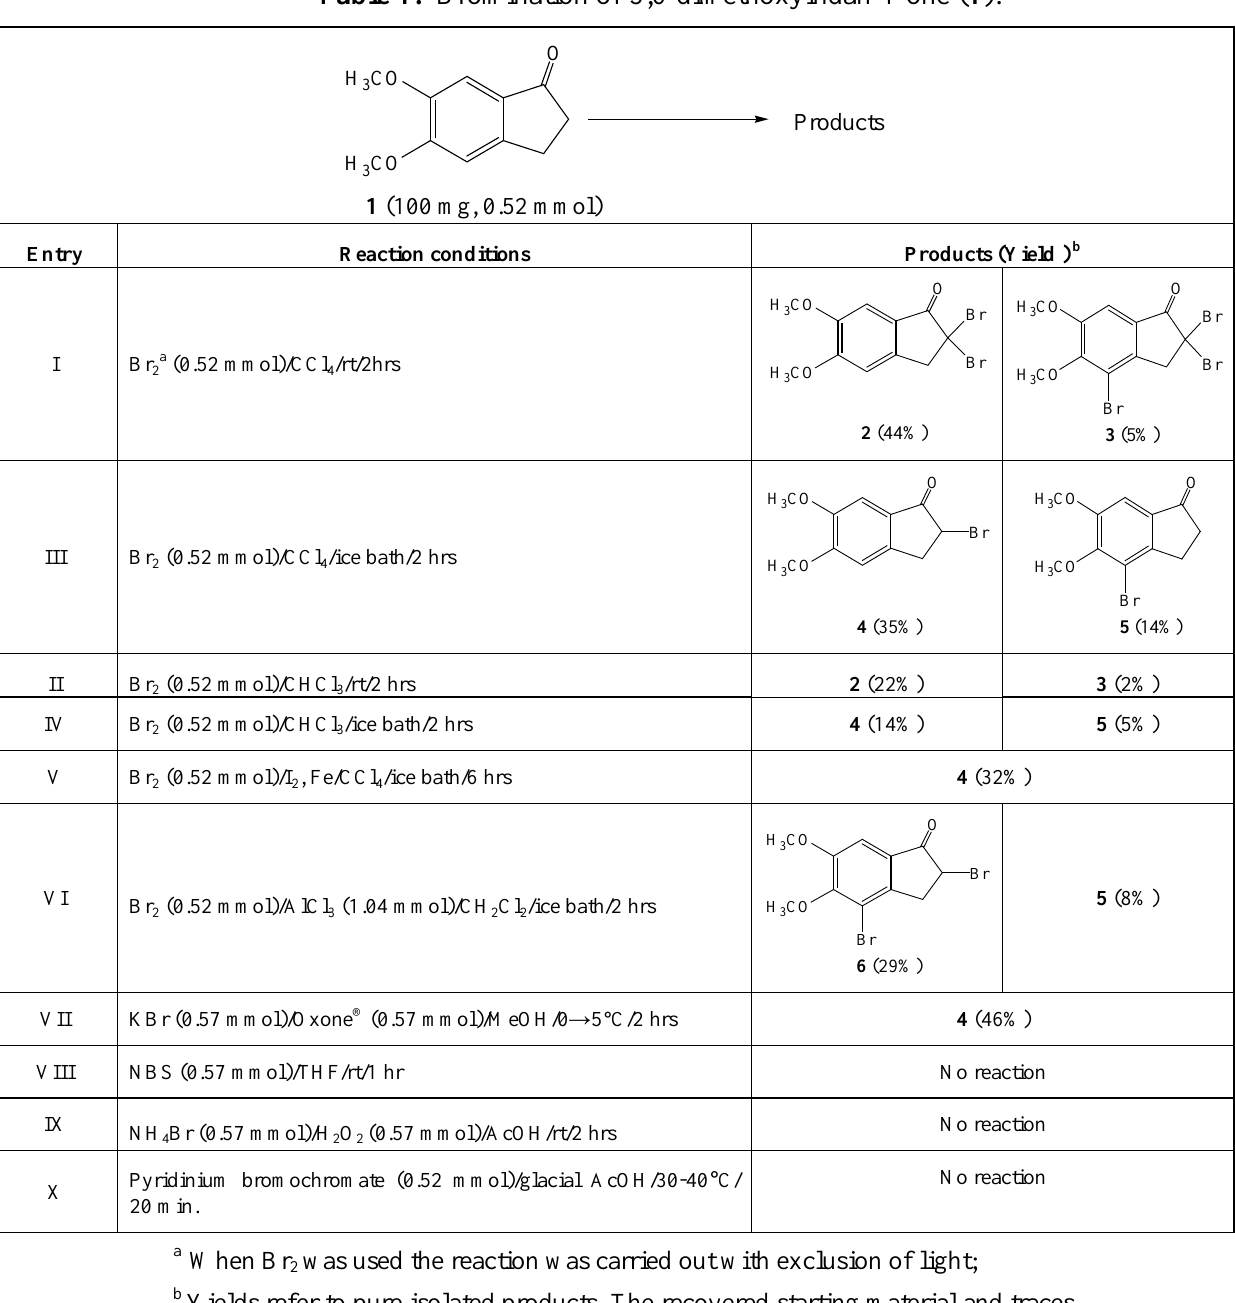
Table 1: Bromination of 5,6-dimethoxyindan-1-one ( 1